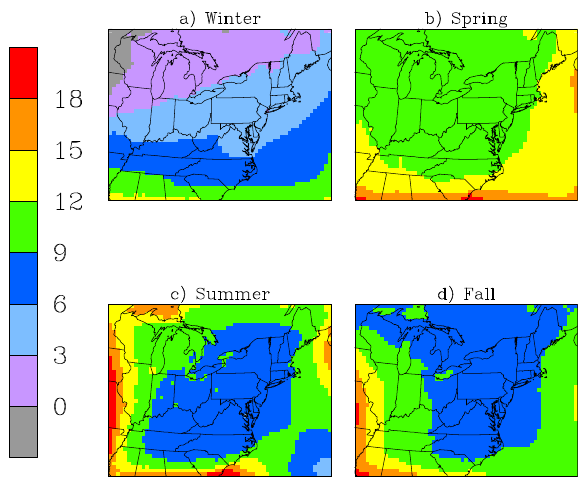
Fig. 11. Differences in seasonal average daily maximum ozone concentrations between the CMAQ/ECHAM5-MOZART and CMAQ/STATIC simulations for model layer 1 for win- ter, spring, summer, and fall, each averaged over the 18 years of the simulation period. The differences were calculated as CMAQ/ECHAM5-MOZART minus CMAQ/STATIC.